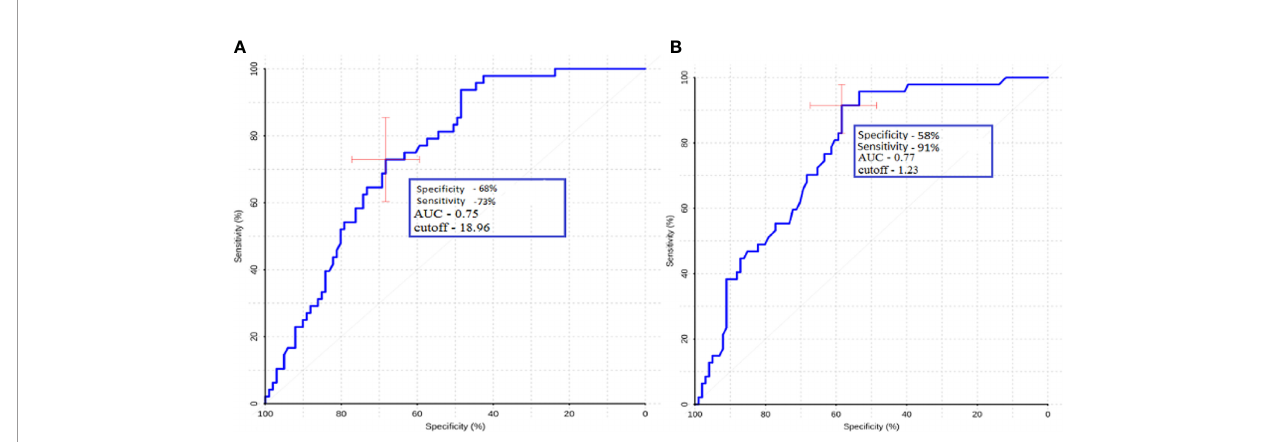
FIGURE 7 | ROC-analysis data obtained by comparing the maximum absolute (A) and normalized (B) TBF values at the ROI1 point in the groups of metastases and glioblastomas. The values of the optimal threshold are presented, in brackets — speci fi city and sensitivity.